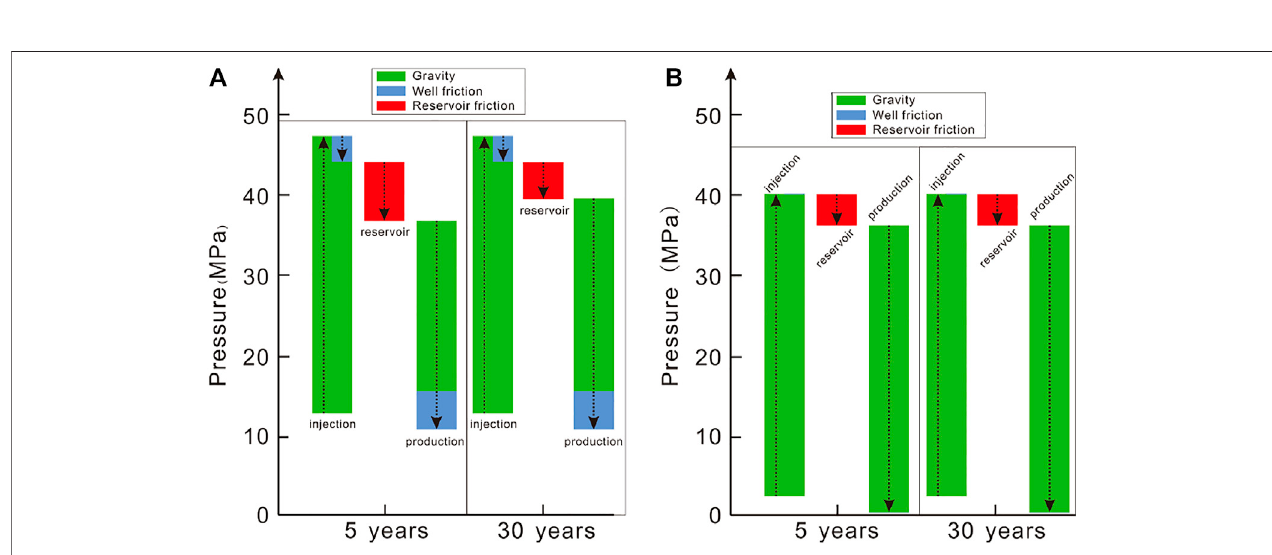
FIGURE 7 | Pressure changes along the fl ow path for (A) the CO 2 -based and (B) H 2 O-based EGS based on simulations. Arrow upward denotes an increase, otherwise it denotes a decrease.